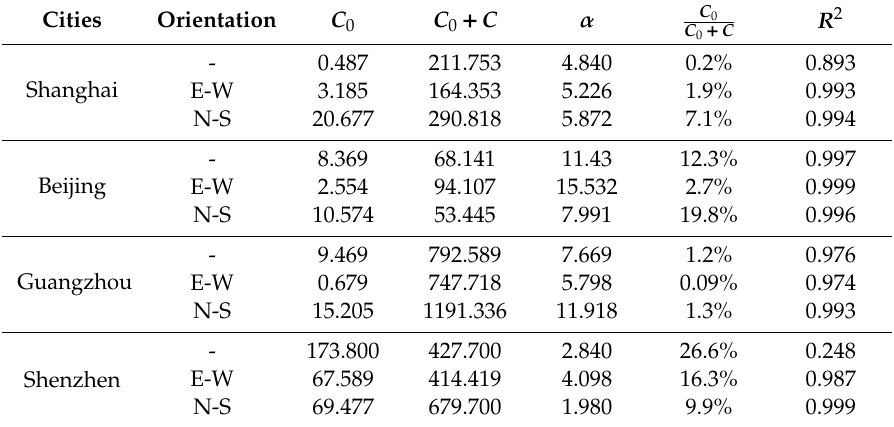
Figure 10. Semi-variance analysis for four cities without considering the change of rainfall in di ff erent directions. Table 4. Key parameters in semi-variance analysis for four